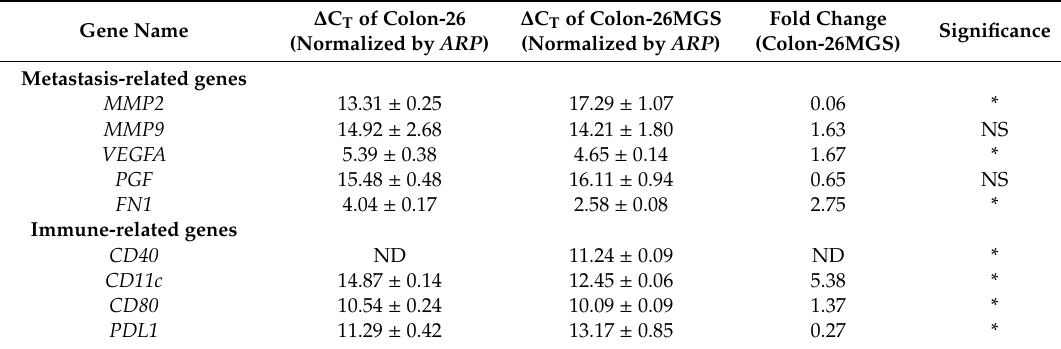
Table 2. Gene expression by